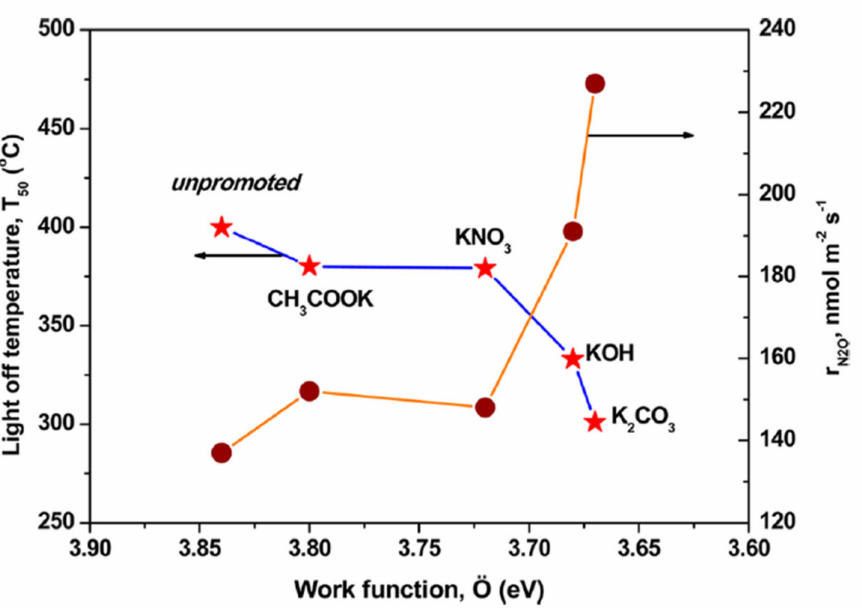
Figure 5. The correlation between precursor and T 50 , reaction rate, and work function [35]. Copyright 2013,